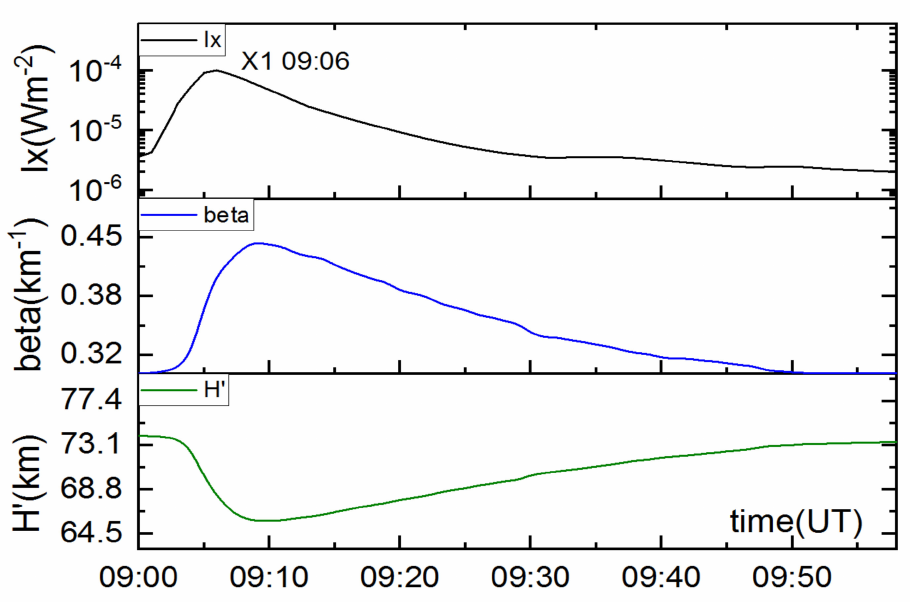
Figure 10. Variations in the effective reflection height H (cid:48) , sharpness β and X-ray irradiance during the occurrence of SF on 11 June 2014 are shown in panels from lower to upper,